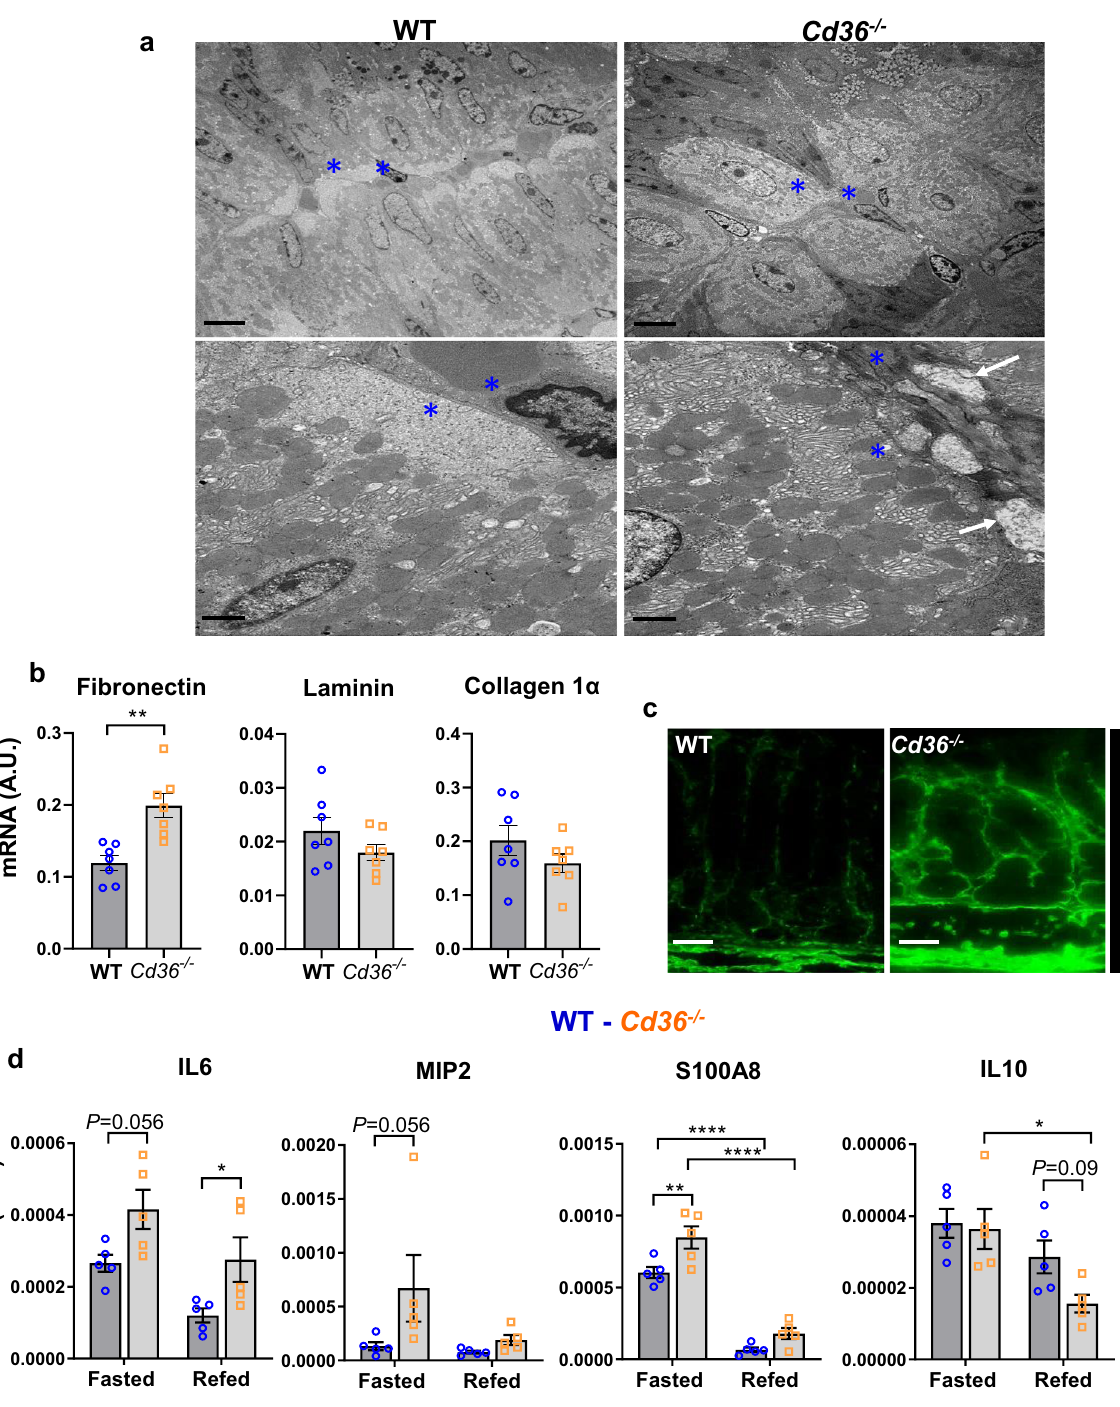
Fig. 3 Increase in extracellular matrix (ECM) deposition and in fl ammation markers in Cd36 − / − stomachs. a Transmission electron microscopy (TEM) of parietal cells in the Cd36 − / − corpus show a lack of mitochondria-free area at the basolateral side (blue asterisks) and ECM deposits between the PC membrane and blood vessels (white arrows). Scale bars: 6 µ m (top) and 1 µ m (bottom) panels. b mRNA of ECM proteins fi bronectin, laminin and collagen1 α in nonfasted mice. c Immunostaining of fi bronectin (green) in corpus of WT and Cd36 − / − mice. Scale bar: 50 µ m. d mRNA of in fl ammation and neutrophil markers. Signi fi cance was calculated using a two-way ANOVA followed by post hoc tests by Sidak multiple comparisons. * P < 0.05, ** P < 0.01, *** P < 0.001. Data are means ± SEM. b n = 7, d n = Cd36 deletion (PC- Cd36 − / − ) (Supplementary Fig. 4a). The expression of markers for PCs, gastrin, or genes related to ECM Cd36 − / − PCs, like PCs of Cd36 − / − mice, showed mitochondrial remodeling or in fl ammation (Supplementary Fig. 4d, e). Unlike migration toward adjacent capillaries but no alterations in the in Cd36 − / − mice, oleate uptake by the corpus was unchanged in PC- Cd36 − / − mice (Supplementary Fig. 4f). The PC- Cd36 − / − plasma membrane or in the appearance of mitochondria (Sup- stomachs recovered from TAM injury like those of fl oxed plementary Fig. 4b, c). The corpus did not show altered